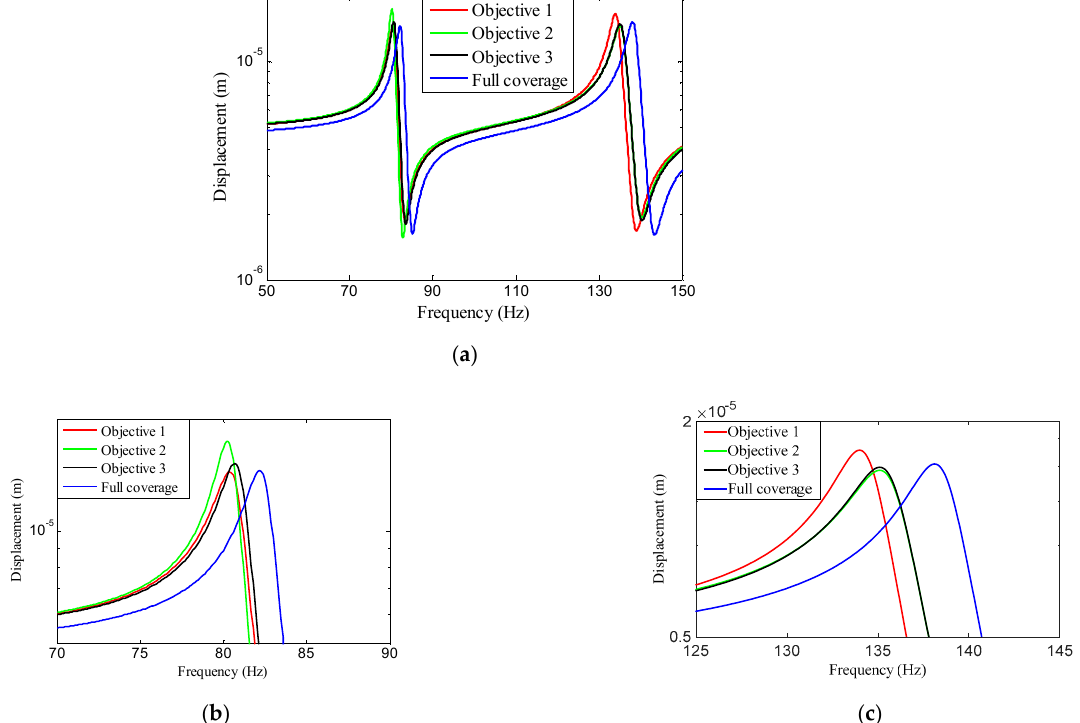
Figure 14. Comparison of the frequency response curves of full coverage structure and optimal designs: ( a ) The frequency response curves from 50 Hz to 150 Hz; ( b ) the detailed description in Mode 1; ( c ) the detailed description in Mode 2.